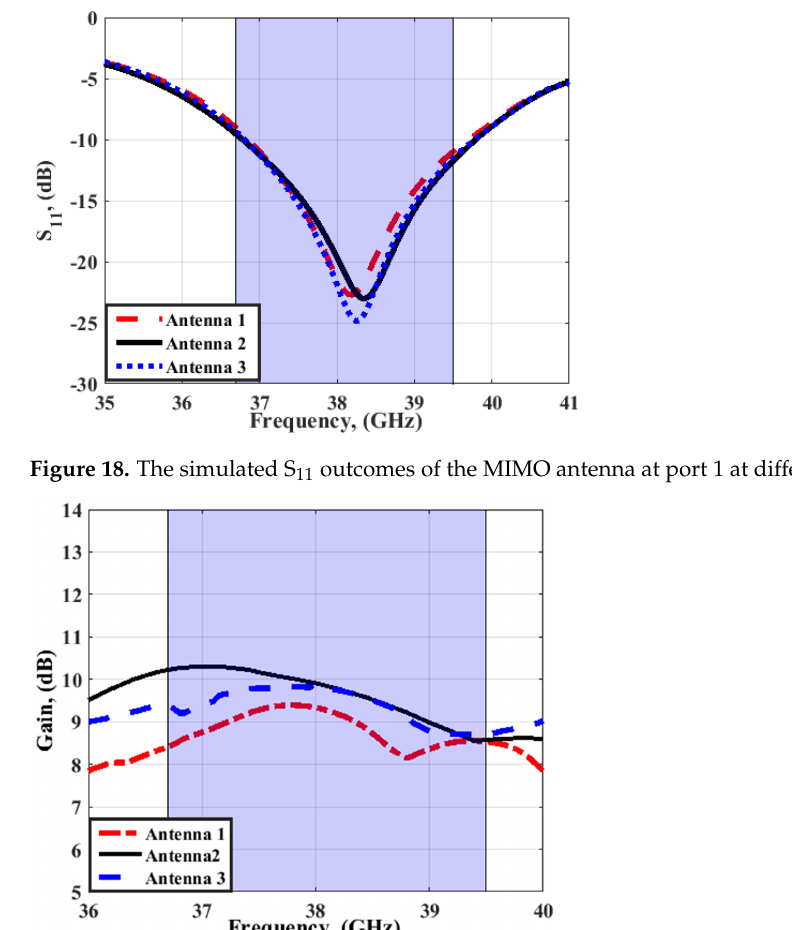
Figure 19. The simulated peak gain of the MIMO antenna at port 1 at different FSS cell sizes.